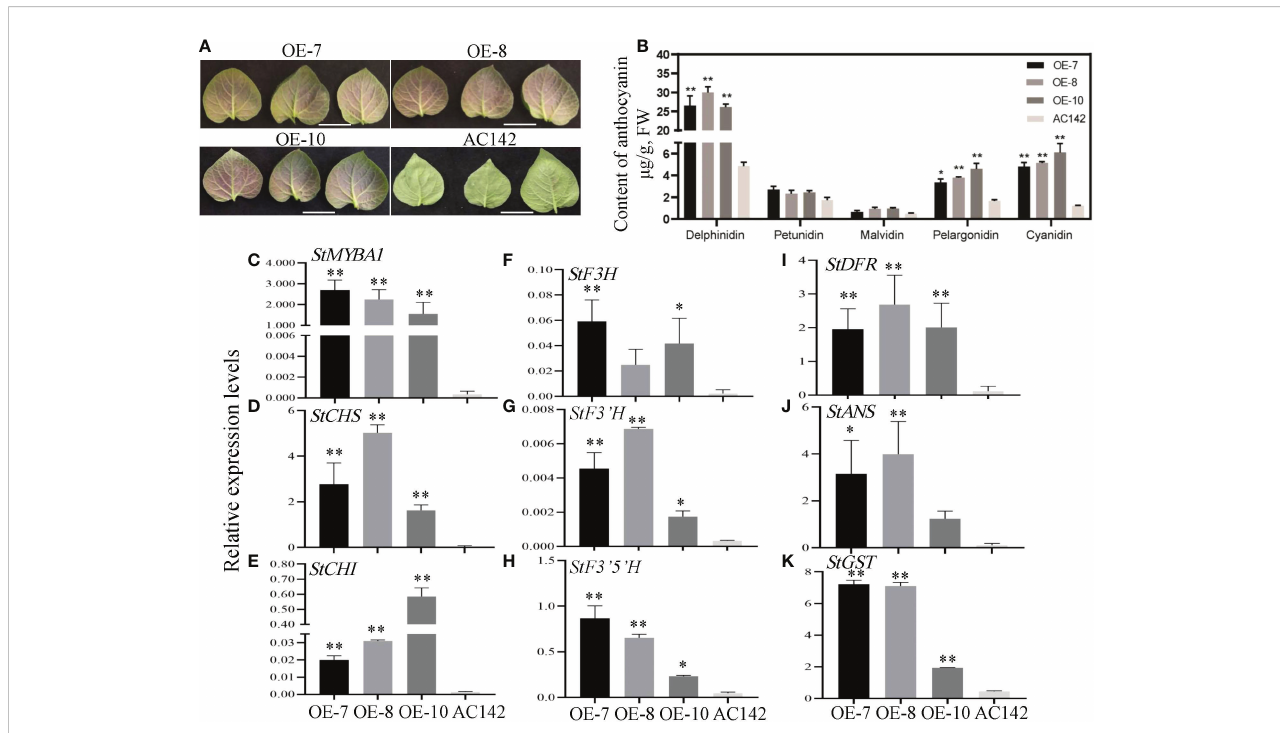
FIGURE 6 Regulation of StMYBA1 gene on anthocyanin biosynthesis in potato. (A) Representative leaves images of StMYBA1-overexpressed transgenic lines (OE-7, OE-8, and OE-10) and the wild type (AC142). Bars=2 cm. (B) The anthocyanin content in the StMYBA1 transgenic leaves. (C – K) The relative expression of StMYBA1 and structural genes in the transgenic leaves. Signi fi cant differences (LSD) between means of the transgenic lines and wild type are indicated by asterisks (* p < 0.05, ** p <